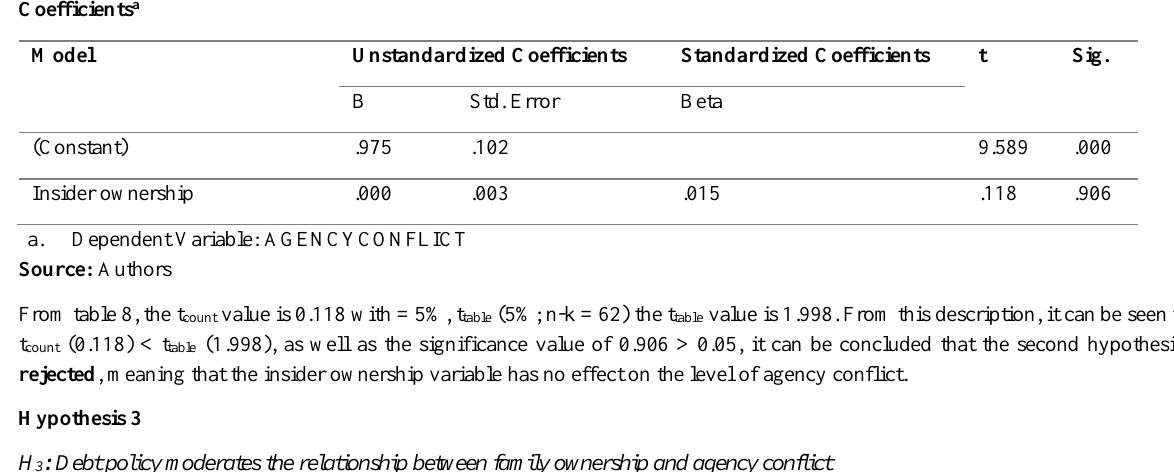
Table 8: Hypothesis 2 Testing